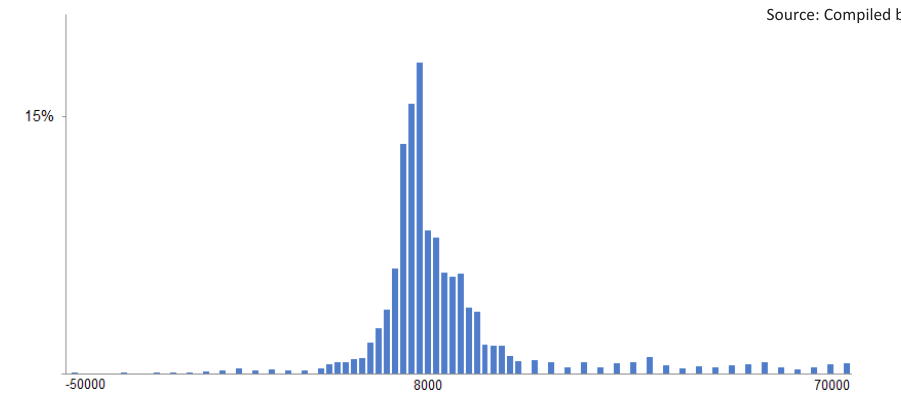
Figure 3. Monte Carlo simulation result of a long-term cryptocurrency investment strategy (the profit/loss per one Bitcoin)